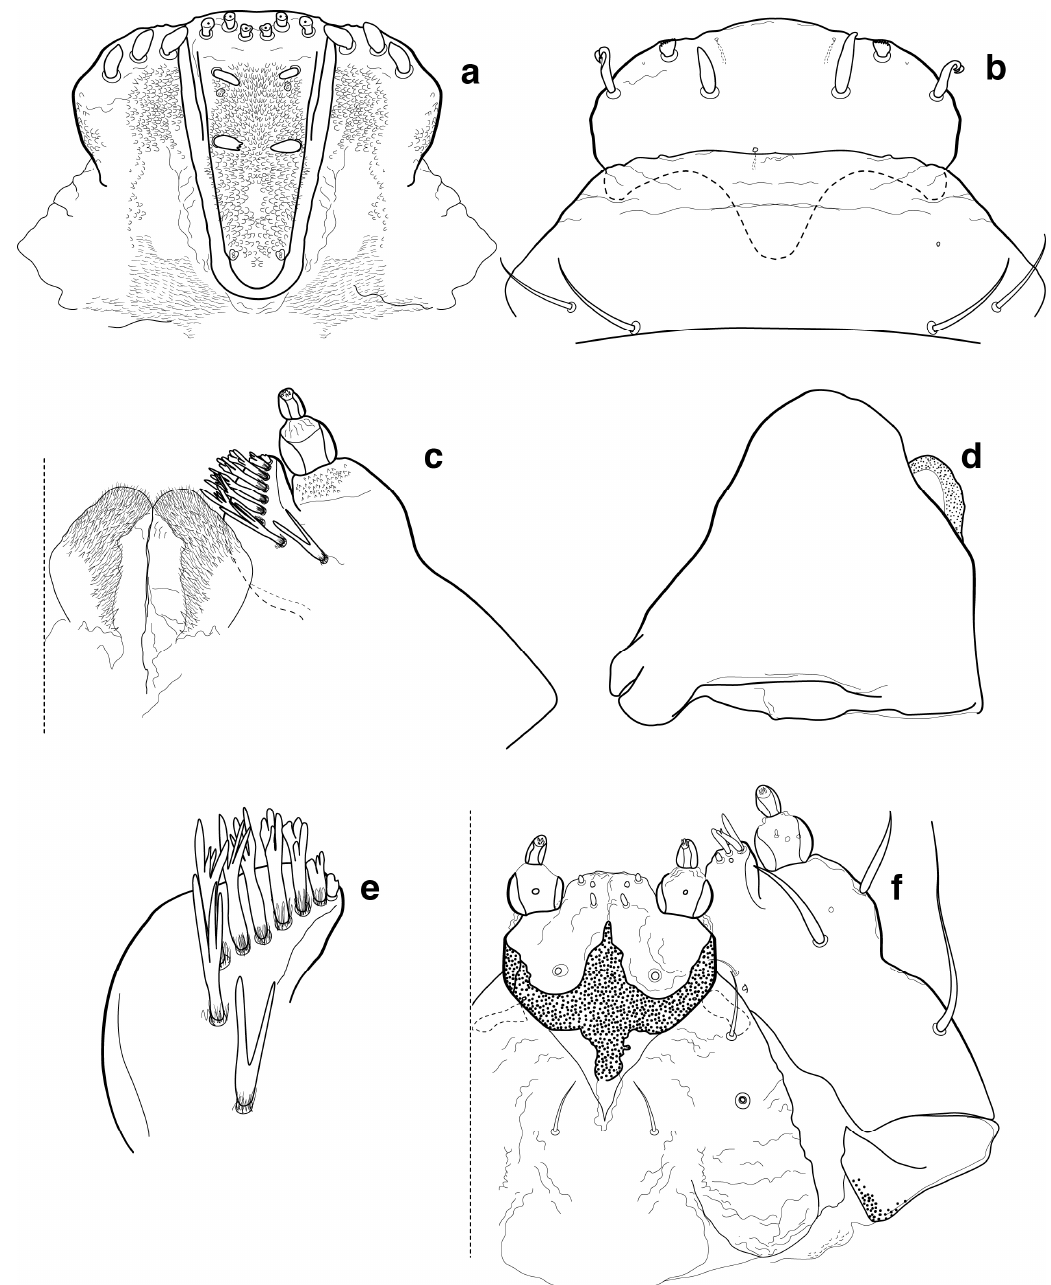
Figure 83. Sparganobasis subcruciata mouthparts: ( a ) epipharynx, setae broken/weathered; ( b ) clypeus and labrum, setae broken/weathered; ( c ) mala and hypopharynx, dorsal view; ( d ) mandible; ( e ) detail, mala and dorsal malar setae, some setae broken/weathered; and ( f ) labio-maxillary complex, ventral view, some setae broken/weathered.